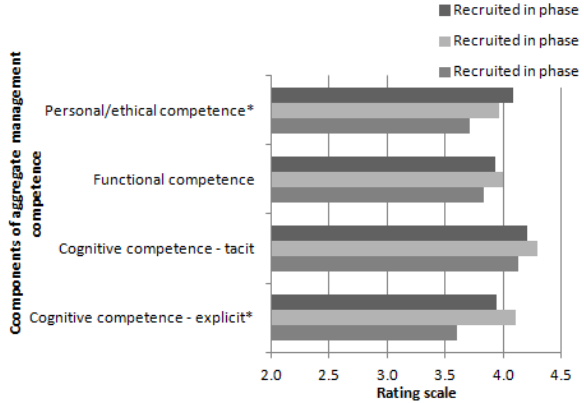
Fig. 7. Components of the aggregate management competence per- ceived to be required in daily work in phase I (1970–1987), II (1987–1998) and III (1998–present); rating scale from 1 to 5, where 1=not at all, 3=to some extent, and 5=extensively.